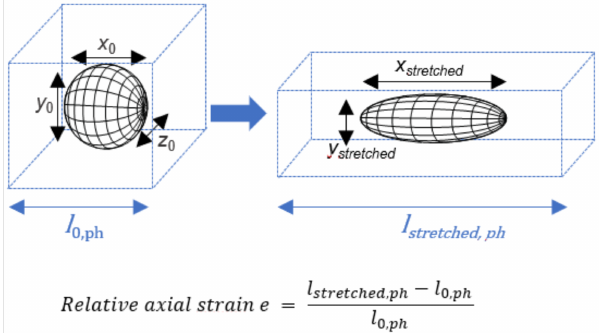
Figure 1. Scheme of the deformation of spherical particles to prolate ellipsoids (black grid) embedded in a phantom matrix (blue dashed box) by phantom stretching. A model for shape prediction should be suitable to describe the correlation of the phantom elongation ε ph or relative axial strain e , and the particle dimensions, such as x stretched or AR, after